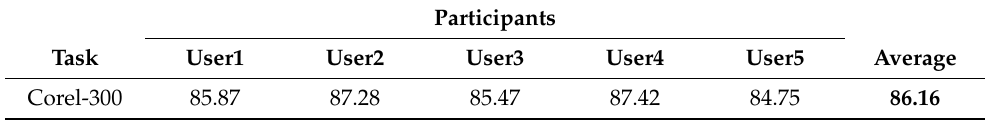
Table 14. Results of multi-instance classification obtained by each participants on Corel-300